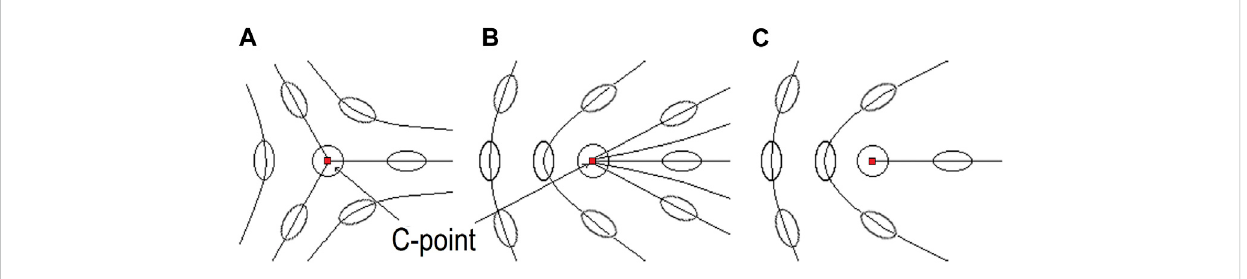
FIGURE 3 Possible structures of the polarization-ellipse fi eld near a C -point (A) “ star ” (the index I C Eq. 3.2 is negative); (B) “ monstar ” and (C) “ lemon ” ( I C is